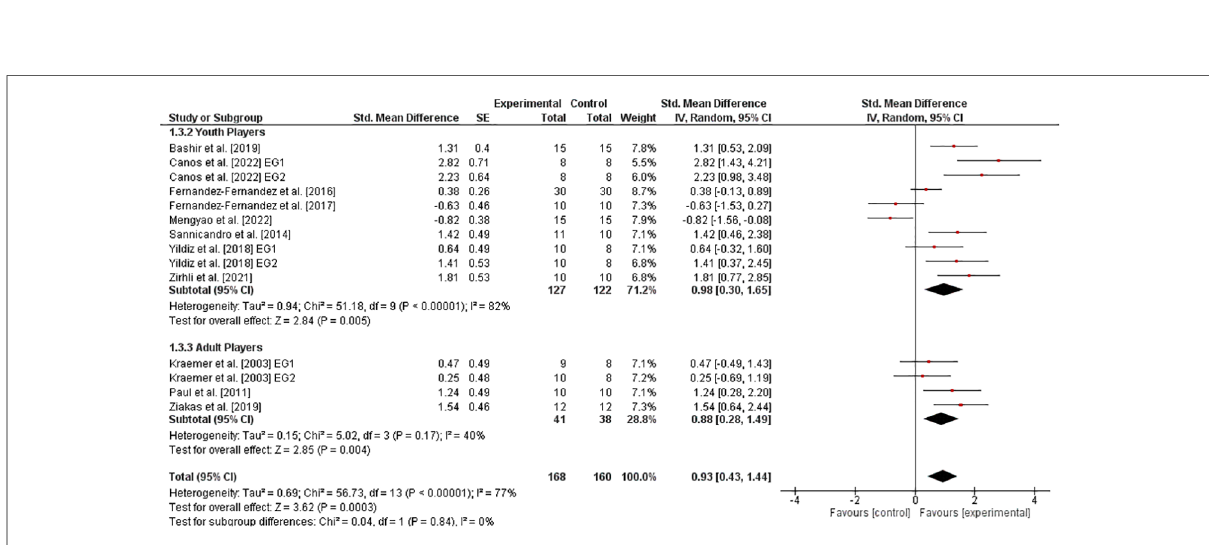
FIGURE 3 Effects of athletic training on measures of agility (e.g., 5-0-5 test time) in healthy youth and adult tennis players. CI =con fi dence interval, df =degrees of freedom, SE =standard error, IV =inverse